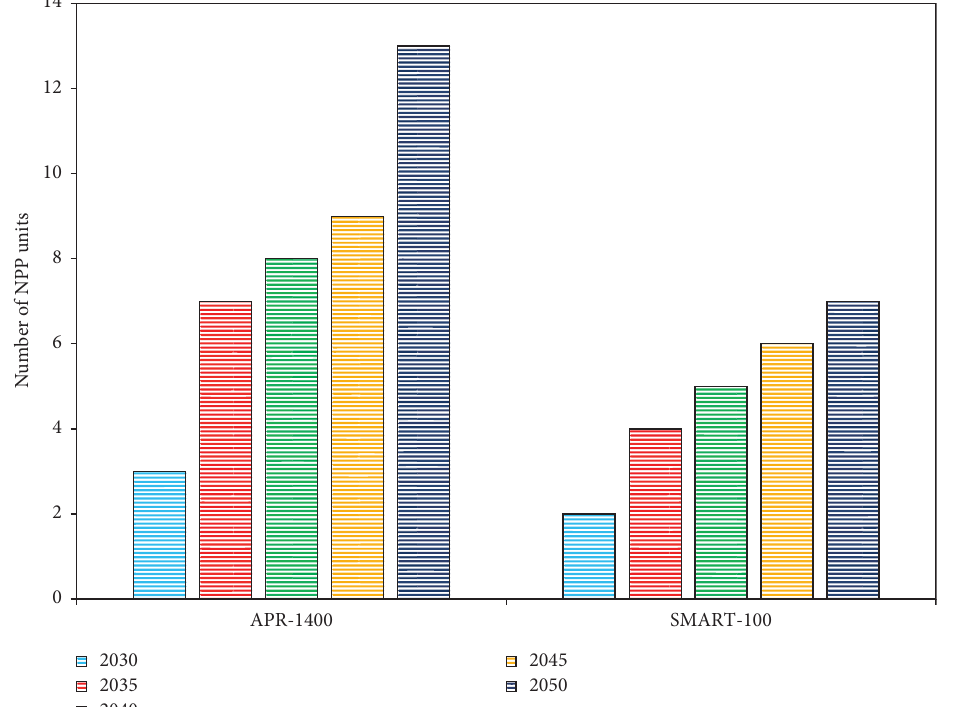
Figure 19: Composition (or ratio) of reactor design in Subscenario